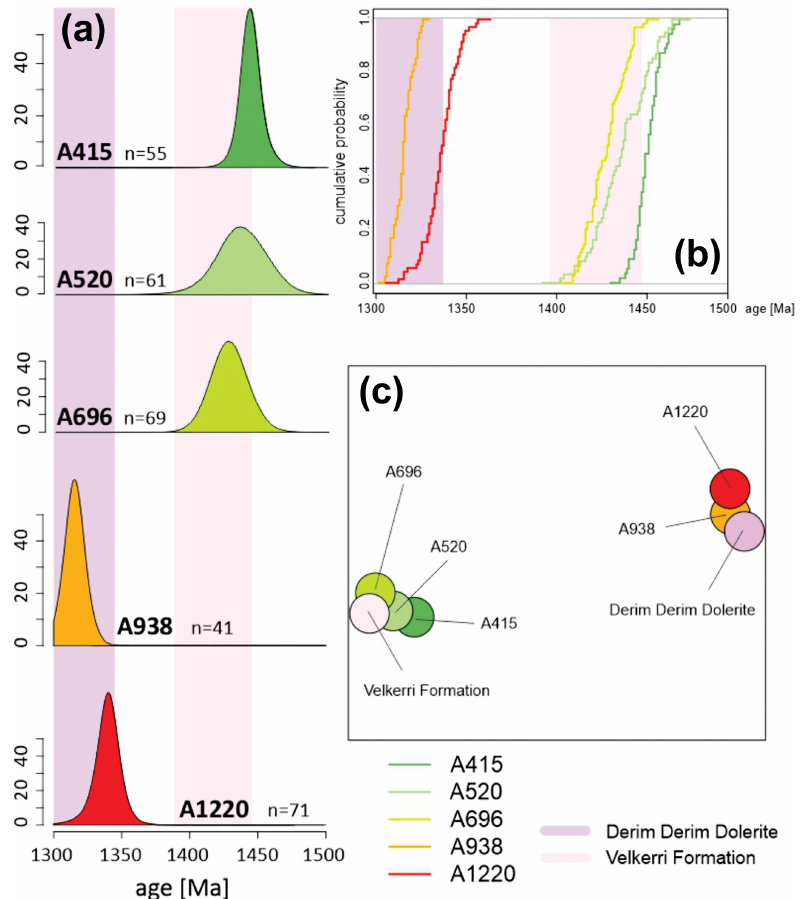
Figure 8. Single-spot ages from samples in this study illustrated by KDE (a) , CAD (b) , and MDS (c) plots. Note that the population of single-spot ages for samples at 415, 520, and 696m depths all overlap with previous Velkerri Formation Re–Os age constraints shown in light pink (Kendall et al., 2009). On the other hand, samples at 938 and 1220m depth are statistically different and instead agree with the Derim Derim Dolerite intrusion ca. 1330–1300Ma (displayed in dark pink) (Bodorkos et al.,